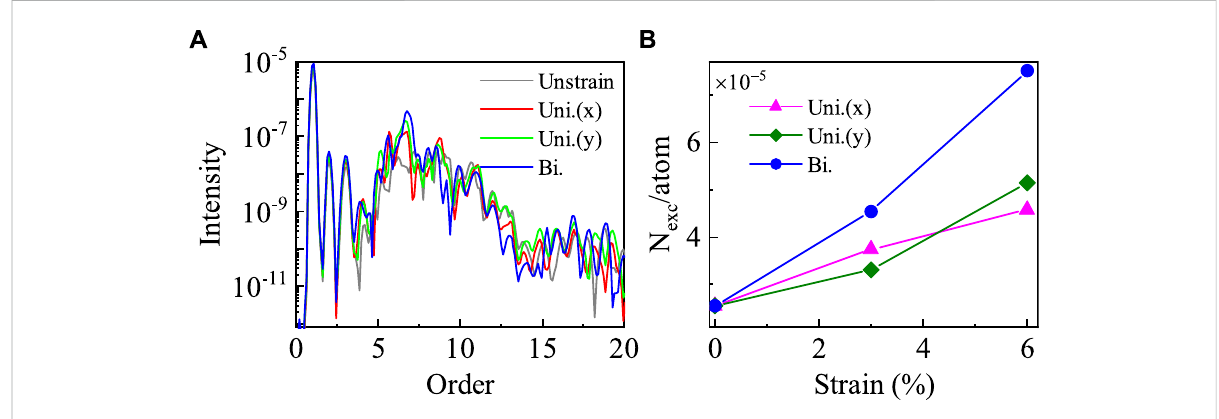
FIGURE 3 (A) ThetotalHHGspectrainthemonolayerhBNwiththestretchingpercentof ε =6%underthelinearpulsepolarizedalongthe x direction.The laser wavelength is 1,600 nm with a peak intensity of 10 12 W/cm 2 . The gray solid line is for the HHG spectra in the strain-free case. (B) The strain- dependent excited electron number after the laser ends for different strains